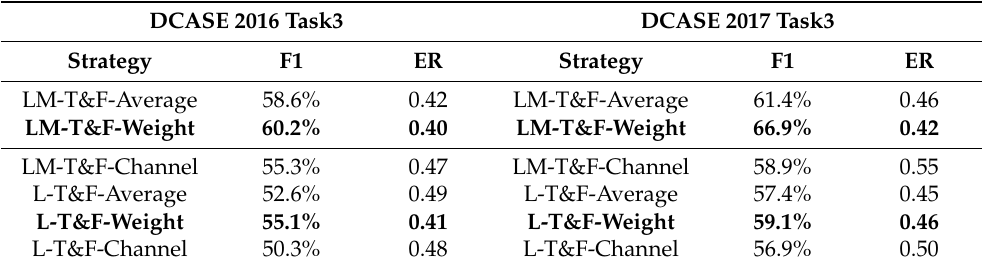
Table 4. The results of fusion strategies on TFFS-CRNN.